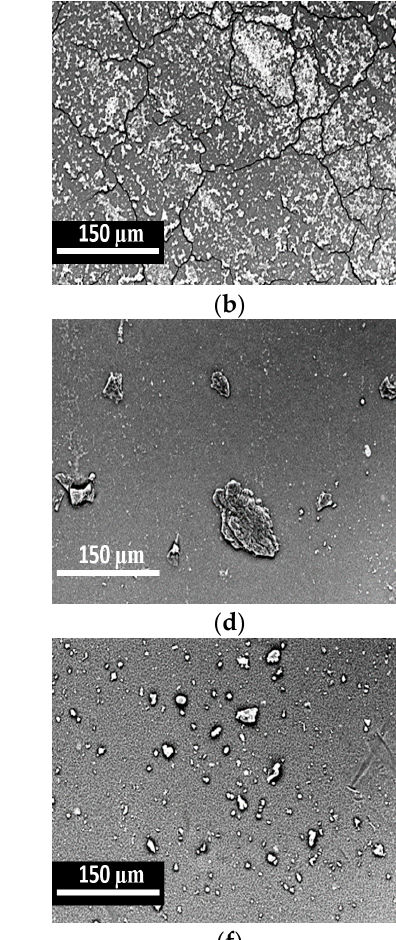
Figure 4. Photographs of membranes before: ( a ) PDecMS; ( c ) PHeptMS; ( e ) MDK-3 and after one month of contact with ABE-fermentation broth: ( b ) PDecMS; ( d ) PHeptMS; ( f ) MDK-3.